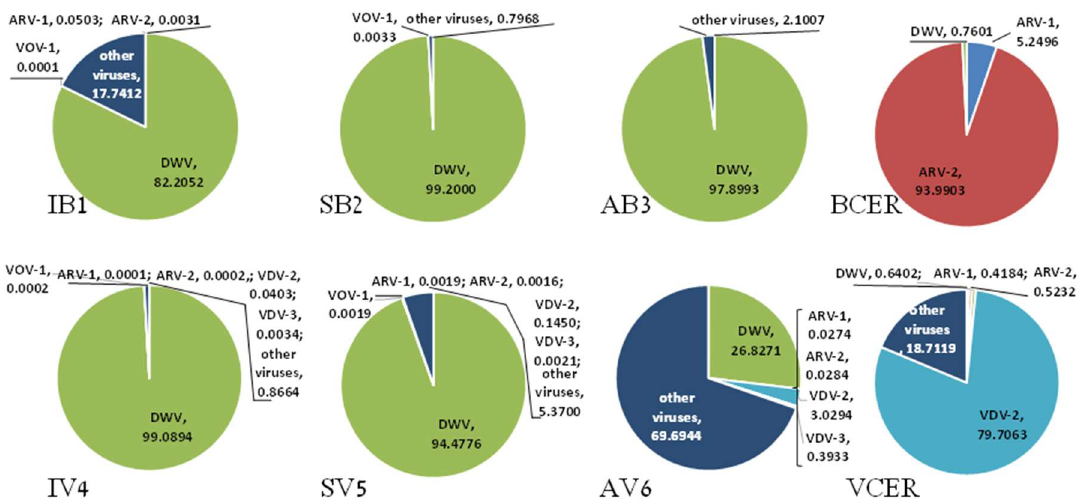
Figure 1. Presence of viruses in honeybee and V. destructor mite by library. Percentage of total viral reads* mapping to viral contigs of the honeybees and V. destructor mites libraries. *Including: DWV and genetic variants, ARV-1, ARV-2, VOV-1, VDV-2, VDV-3, and other viruses (11 more, see Table 1), cutoff at 0.0001%.